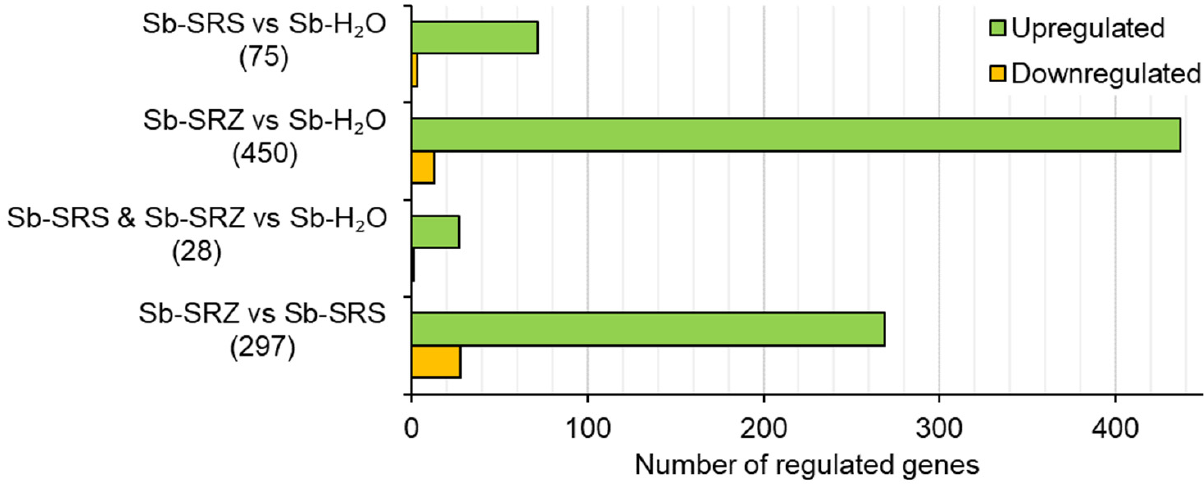
Figure 3. S. reilianum infection leads to gene expression in sorghum. Bar chart showing distribution of significantly differentially expressed ( p ≤ 0.05) sorghum genes in the indicated comparisons. Infection with SRZ leads to more upregulated genes than infection with SRS.